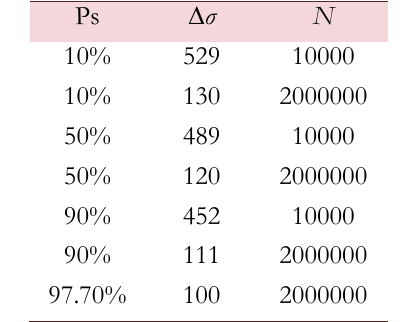
Table 3: Summary of the statistical re-analysis for the hot-dip galvanized